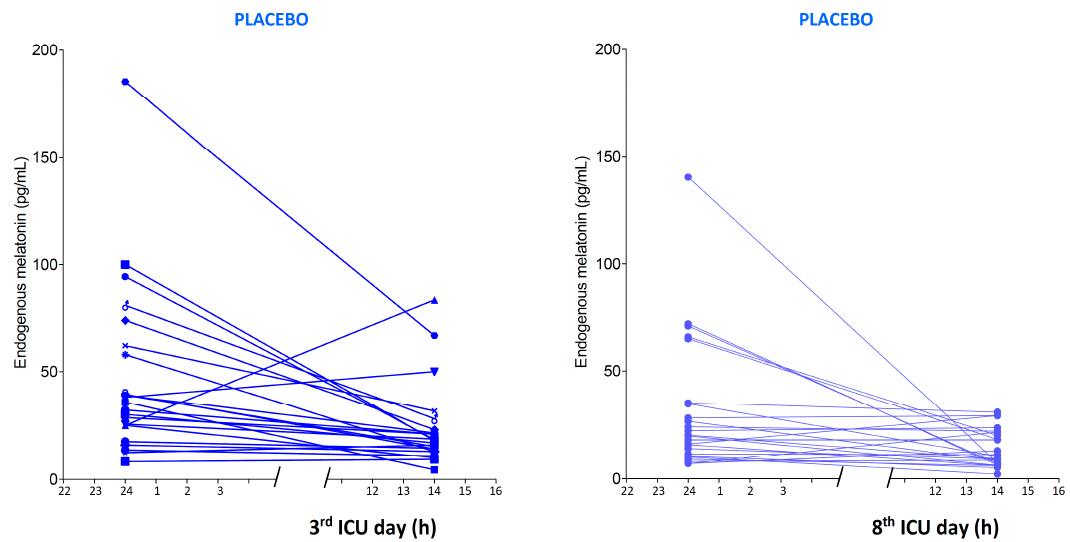
Figure 2. Endogenous melatonin secretion in the 3rd and 8th day of ICU measured at midnight (24) and at 14.00 h (14), in patients treated with placebo. The median (25; 75 percentiles) values were 33.8 (25; 62) vs. 20.0 (12; 35) pg/mL at midnight and 16.8 (13; 23) vs. 10.9 (7; 22) pg/mL at 14:00 h, at the 3rd and 8th day, respectively.